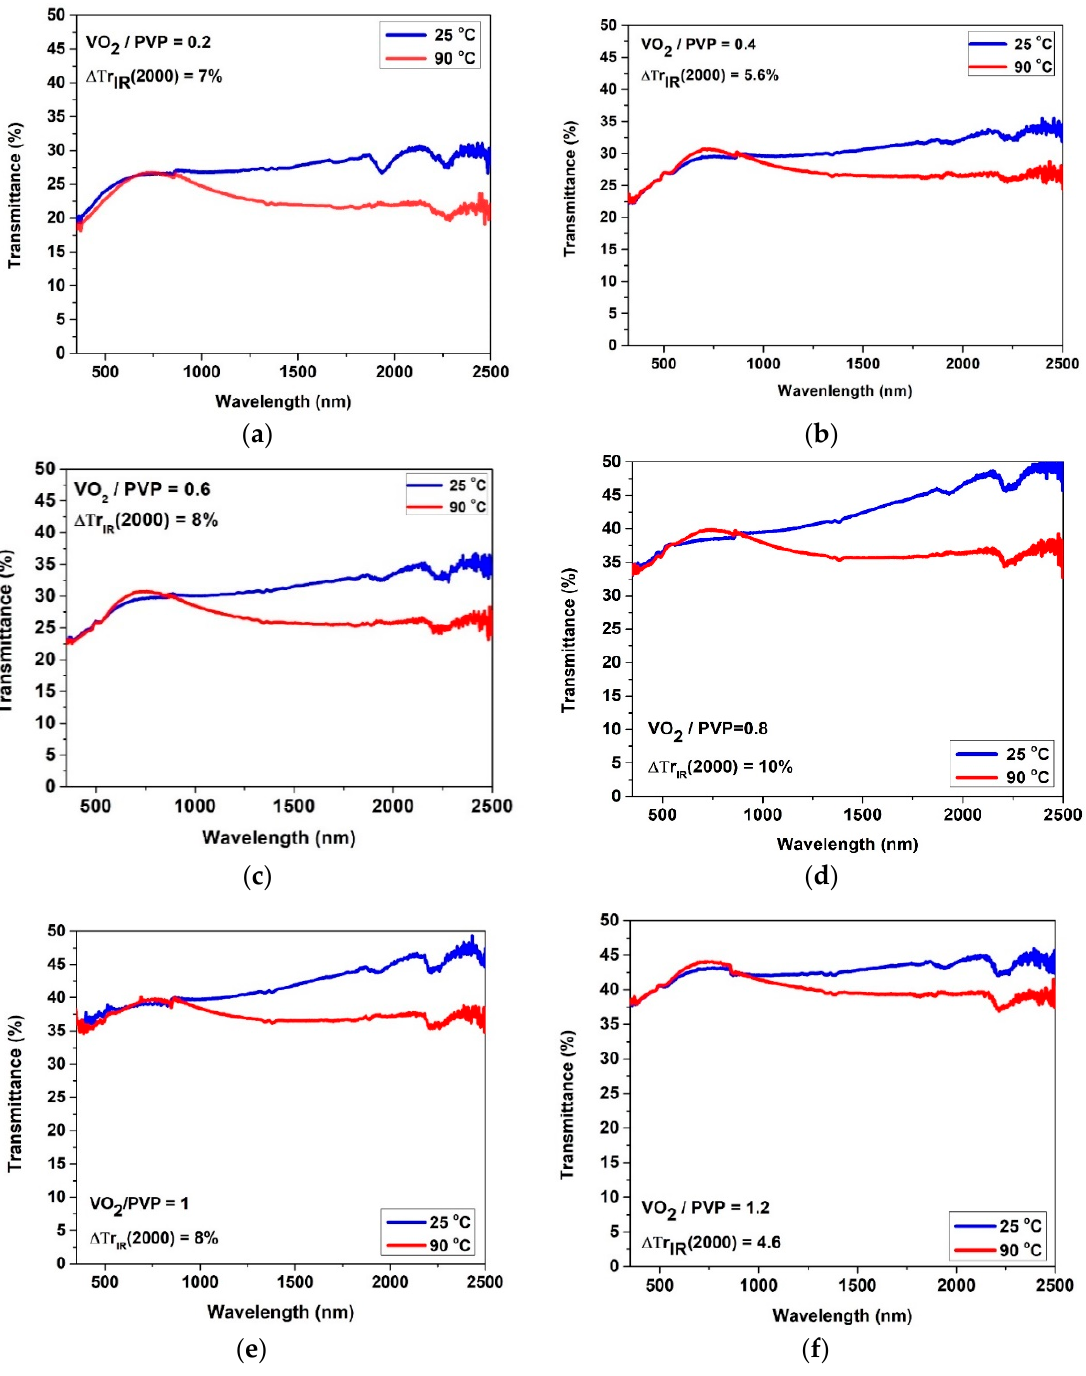
Figure 4. Transmittance spectra at 25 (blue line) and 90 °C (red line) of VO 2 /PVP nanocomposite films prepared with different molar ratios of VO 2 /PVP: ( a ) 0.2, ( b ) 0.4, ( c ) 0.6, ( d ) 0.8, ( e ) 1.0, and ( f ) 1.2. Table 1. Optical characteristics of VO 2 /polymer nanocomposite films.